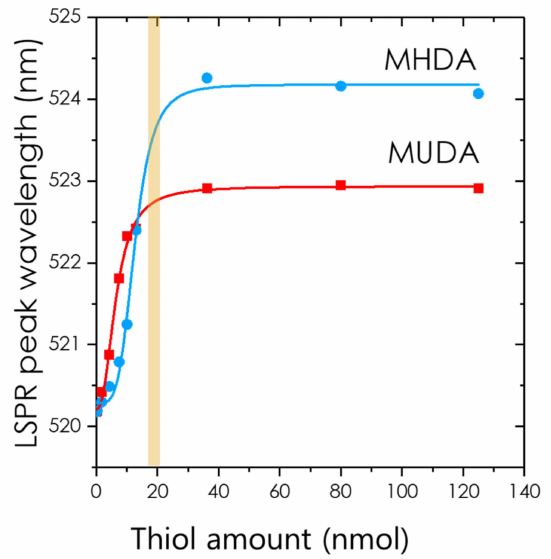
Figure 4. Evolution of the LSPR peak wavelength as a function of the added amount of thiol molecules in the case of MUDA (red square) and MHDA (blue circle). The curves are guides for the eye. The wide vertical line represents the transition threshold to the plateau and indicates that the full coverage of the nanoparticle is